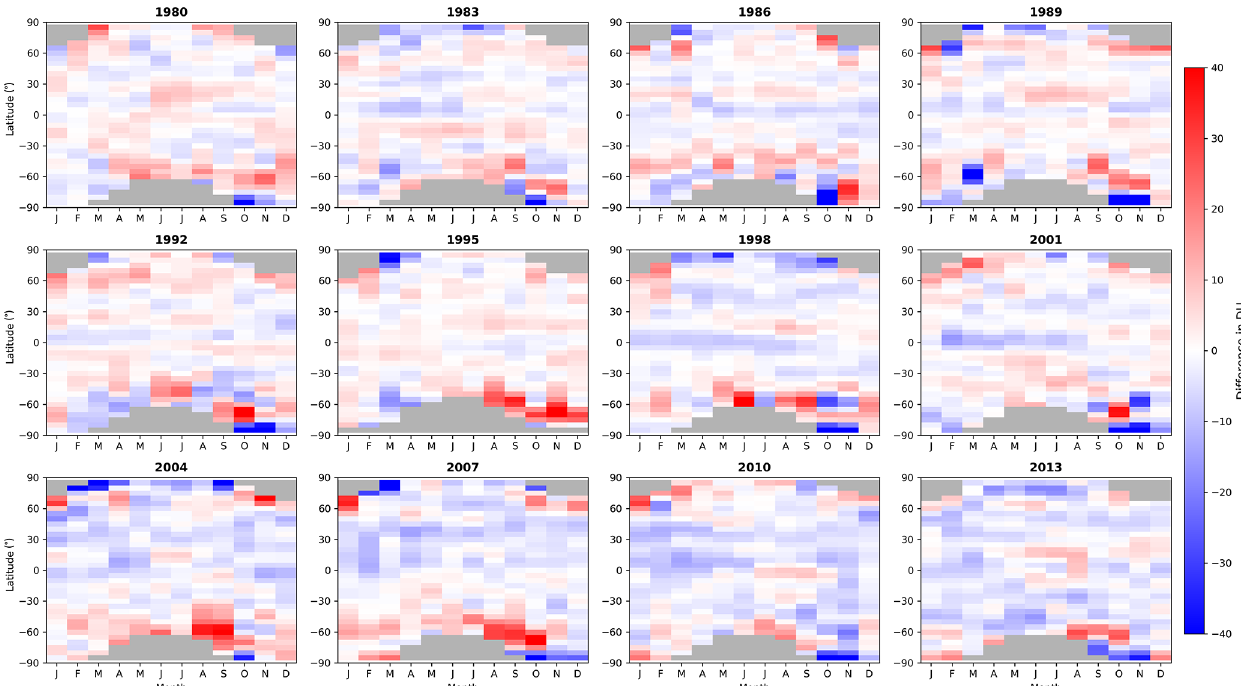
Figure 8. Monthly mean differences between NIWA-BS TCO and the WOUDC database for 12 selected years.